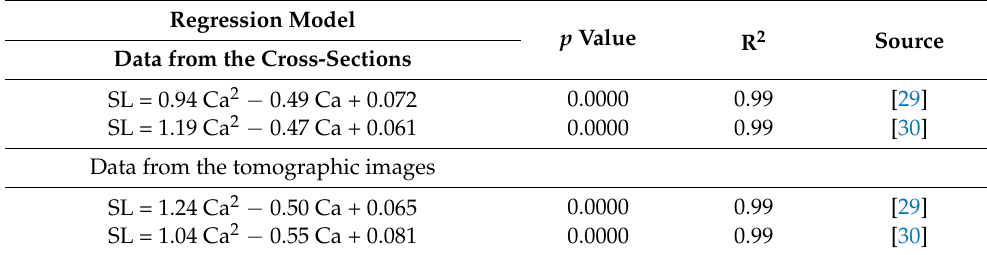
Table 2. Regression models for inferring the percentage of strength loss (SL) as a function of the percentage of the trunk diameter occupied by cavity (Ca) obtained from data of the cross-sections and tomographic images applied to the equations proposed in the literature. Regression Model Regression Model p Value R 2 Source Data from the Cross-Sections